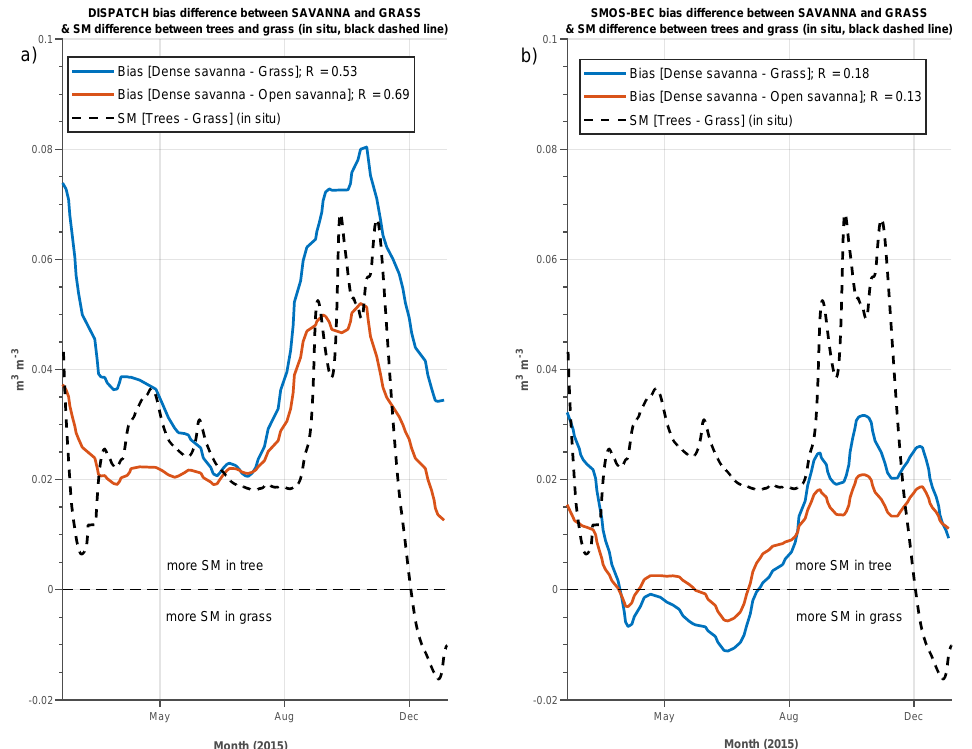
Figure 4. Mean soil moisture (SM) bias differences between dense savanna and grass pixels (blue lines) and between dense savanna and open savanna (red lines) for DISPATCH ( a ) and SMOS-BEC ( b ) through 2015. The black dashed line shows the evolution of the SM differences between the trees and the grass sites measured with the in situ probes, included as the reference for the comparison of the evolution (the differences of SM biases are represented with the red and blue lines while we show the evolution of SM differences with the black dashed line; therefore, the absolute values are not comparable, but the evolution is). The correlations between the red/blue lines and the black one are included in the legend, in order to indicate the ability of these products to represent the seasonal evolution of these